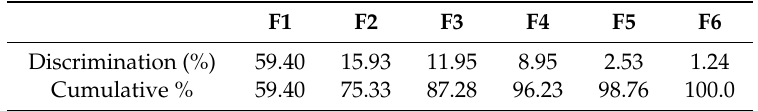
Table 4. Discriminant functions for the total